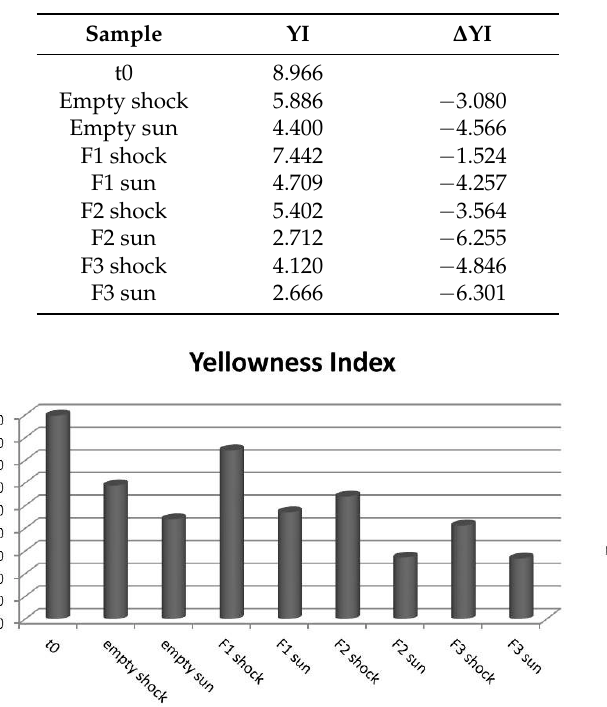
Table 6. YI and ∆ YI values of non-treated and treated packaging samples. Table 6. YI and Δ YI values of non-treated and treated packaging samples.